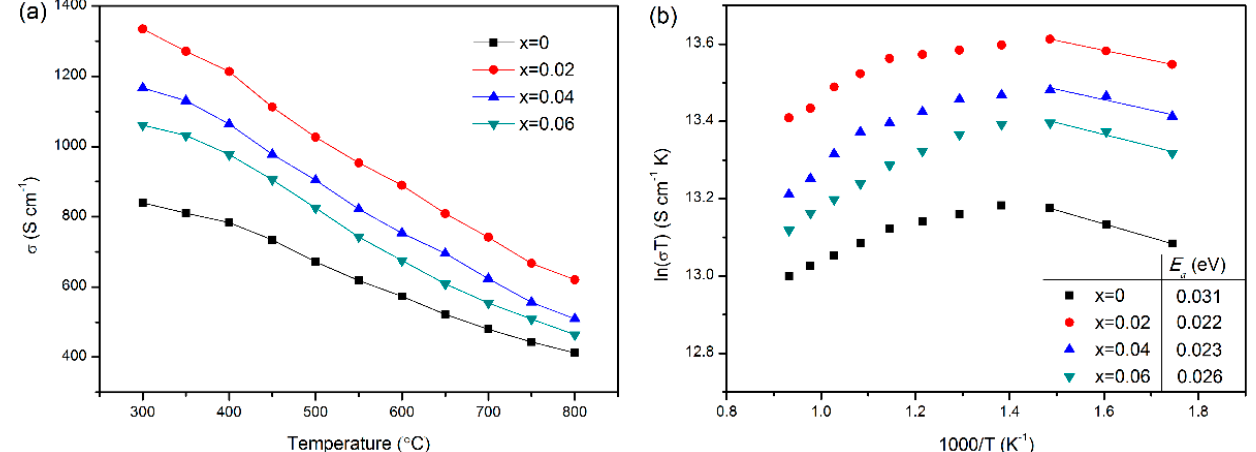
Figure 5. ( a ) Electrical conductivity and ( b ) Arrhenius plots of LBCM x ( x = 0–0.06) as a function of temperature.